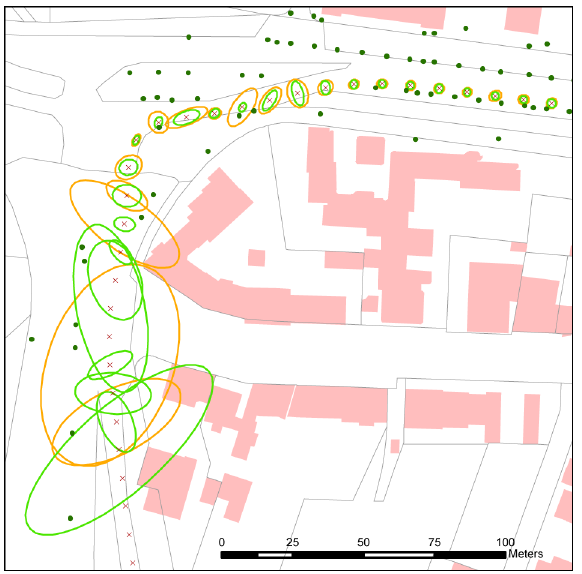
Figure 4. Positioning accuracy for single positions drawn as error ellipses (green: opening angle 100°, orange: opening angle 60°). All ellipses scaled by a factor of 20. (Red crosses: positions on trajectory, green dots: objects in reference map.)